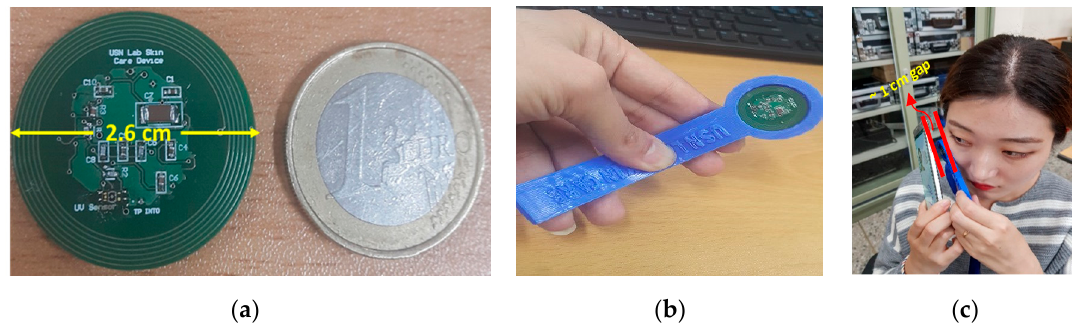
Figure 3. ( a ) Dimensions of the smart skincare sensor device tag; ( b ) skincare sensor device tag enclosed within the flexible 3D-printed object; ( c ) operating distance of the skincare sensor device tag from the NFC smartphone.